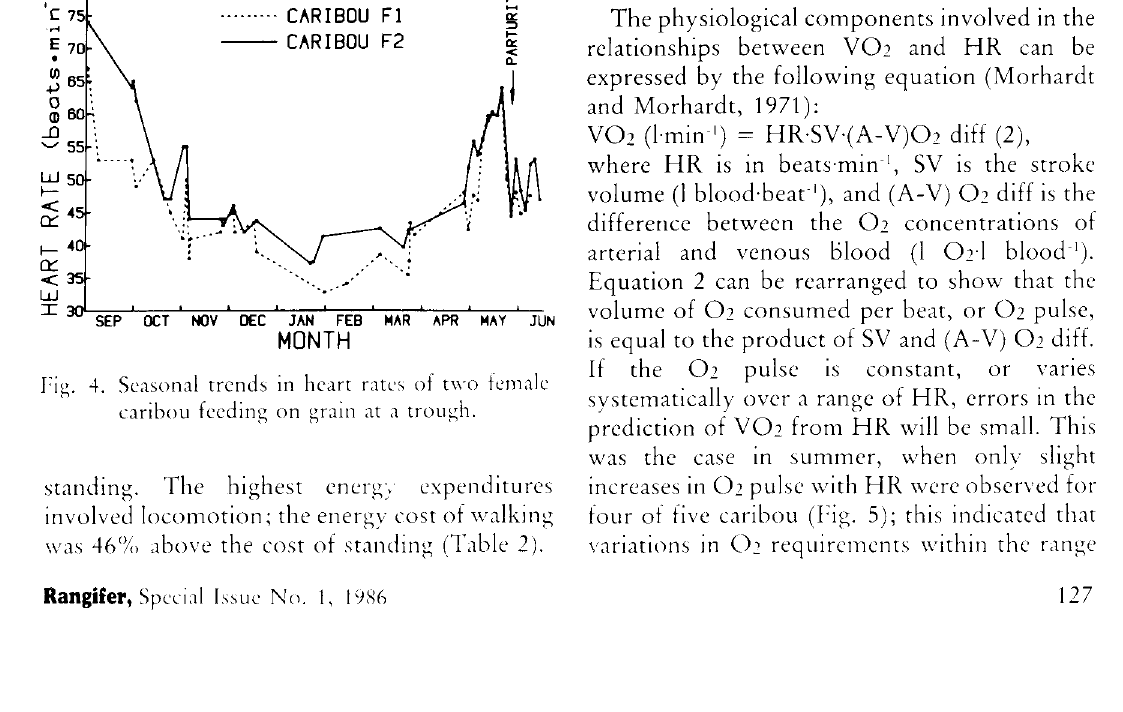
Fig. 4. Seasonal trends in heart rates of two female caribou feeding on grain at a